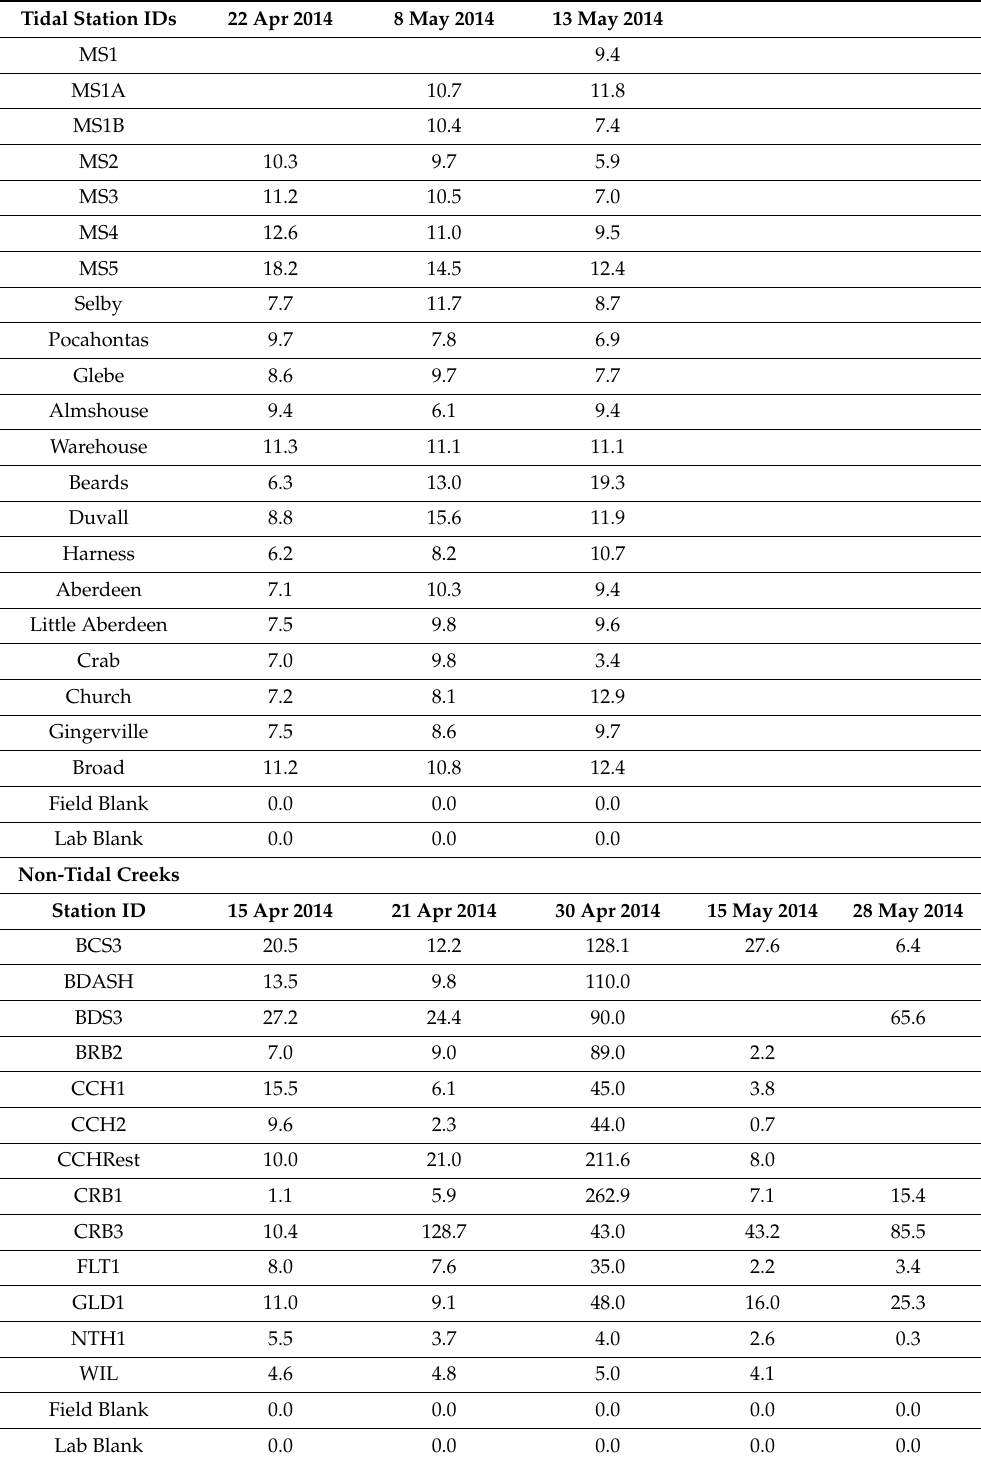
Table 3. Total suspended sediment results for the estuary, triblets, and freshwater